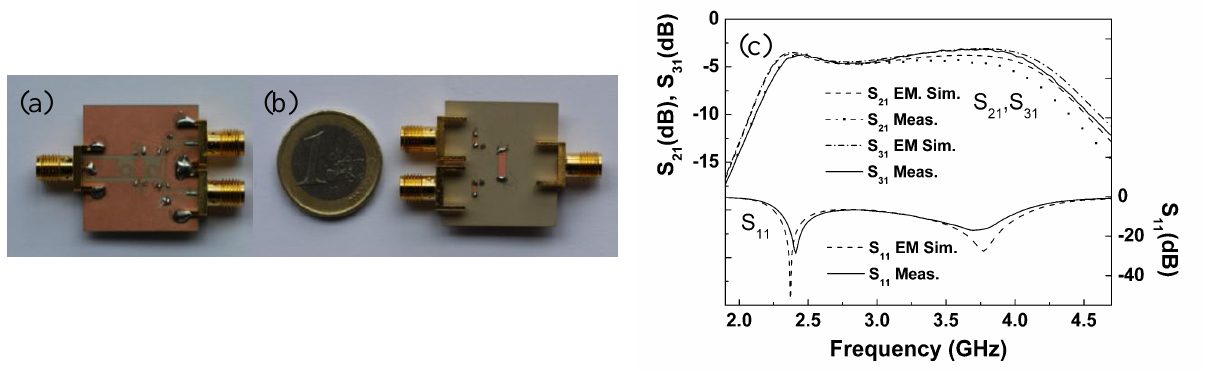
Figure 19. Fabricated dual-band power divider and frequency response. ( a ) Top view. ( b ) Bottom view. ( c ) Power division ( S Rogers RO3010 with thickness h = 0.635 mm and dielectric constant  are: l = 9 mm, W = 4 mm, G = 0.74 mm. For the open complementary split ring resonator: r = 0.9 mm, c = 0.2 mm, d = 0.2 mm. For the open split ring resonators: r ext c = 0.3 mm, d = 0.2 mm. The wide metallic strip in the back substrate side has been